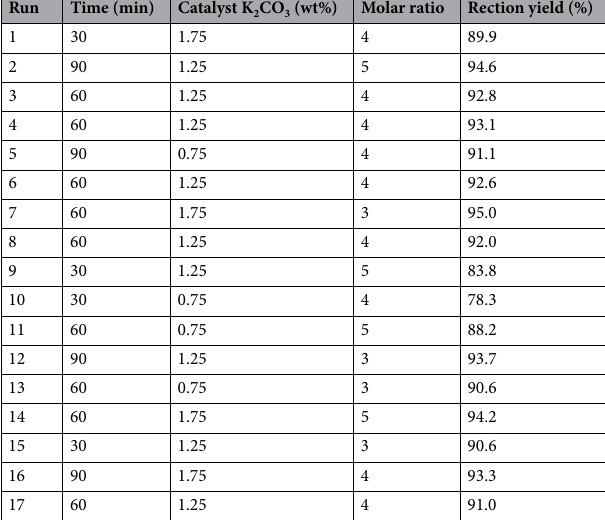
Table 3. Experiments carried out by Box Behnken